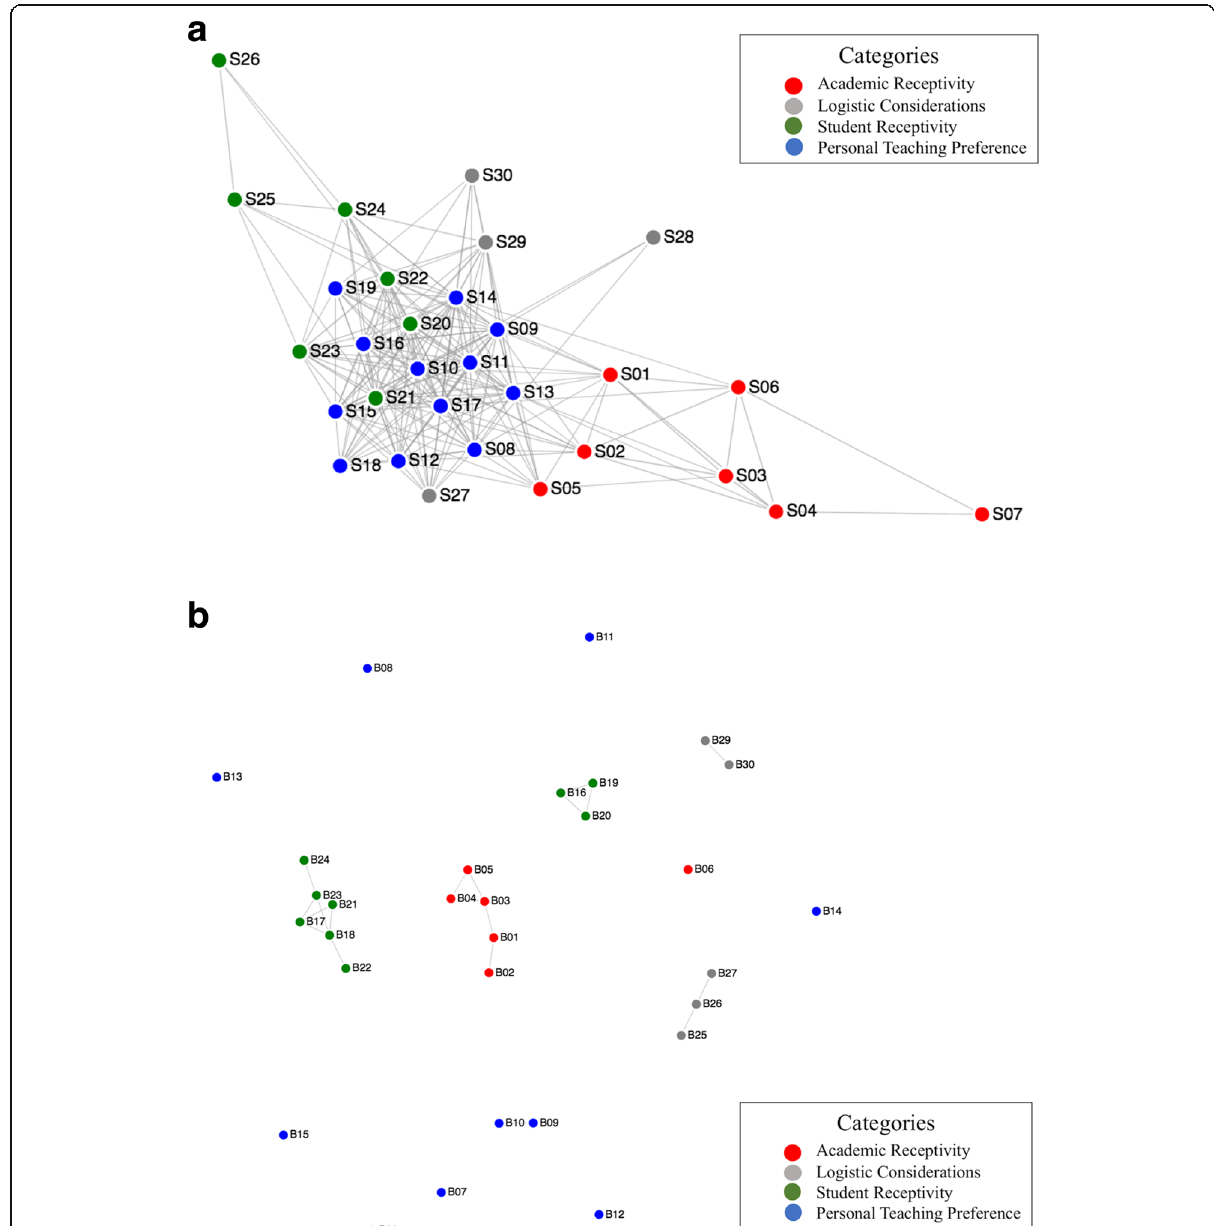
Fig. 2 Visualization of the strongly interconnected structure of perceived supports ( a ) and the isolated structure of barriers ( b ) from 558 instructors. Each node represents a support item ( a ) or barrier item ( b ) and the color of the node represents its category (see